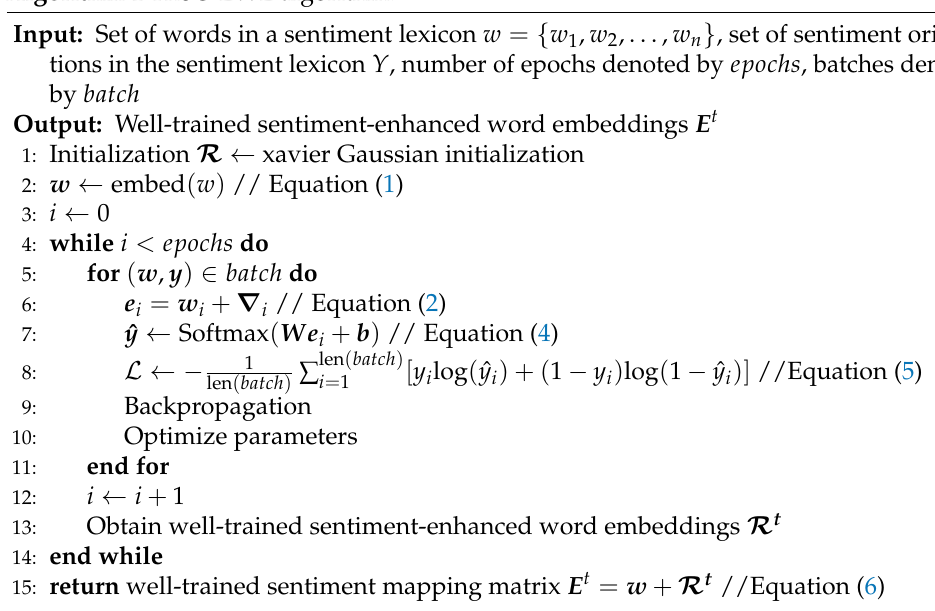
Algorithm 1 The S-EWE algorithm.